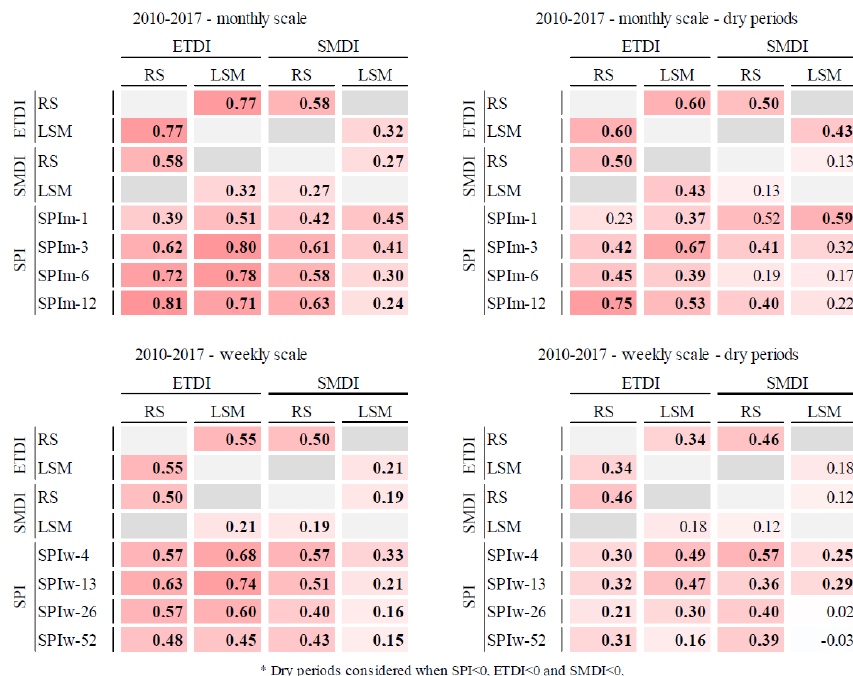
Table 1. Matrices of significant (in bold) correlation coefficients considering a p values of = 0 . 05 for pairs of indices at the monthly and weekly scale for the period 2010–2017 of the SPI, ETDI and SMDI series and the corresponding dry-period subsets. Higher correlation values show a more intense red color. Since the correlations of interest refer to comparing the same type of data source for different indices, dark grey cells identify unsuitable combinations for the analysis such as comparing RS results from one index with LSM results from another